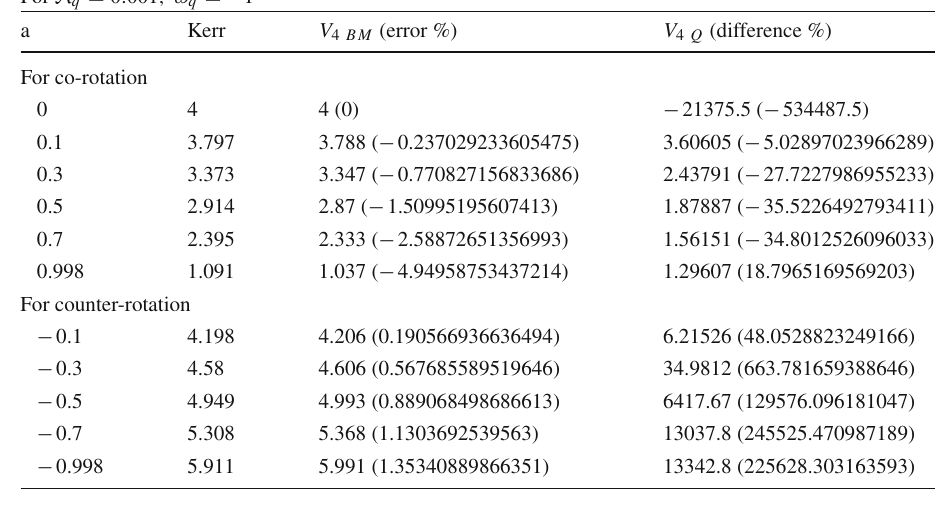
PNPs for moderate DE effect in radiation era